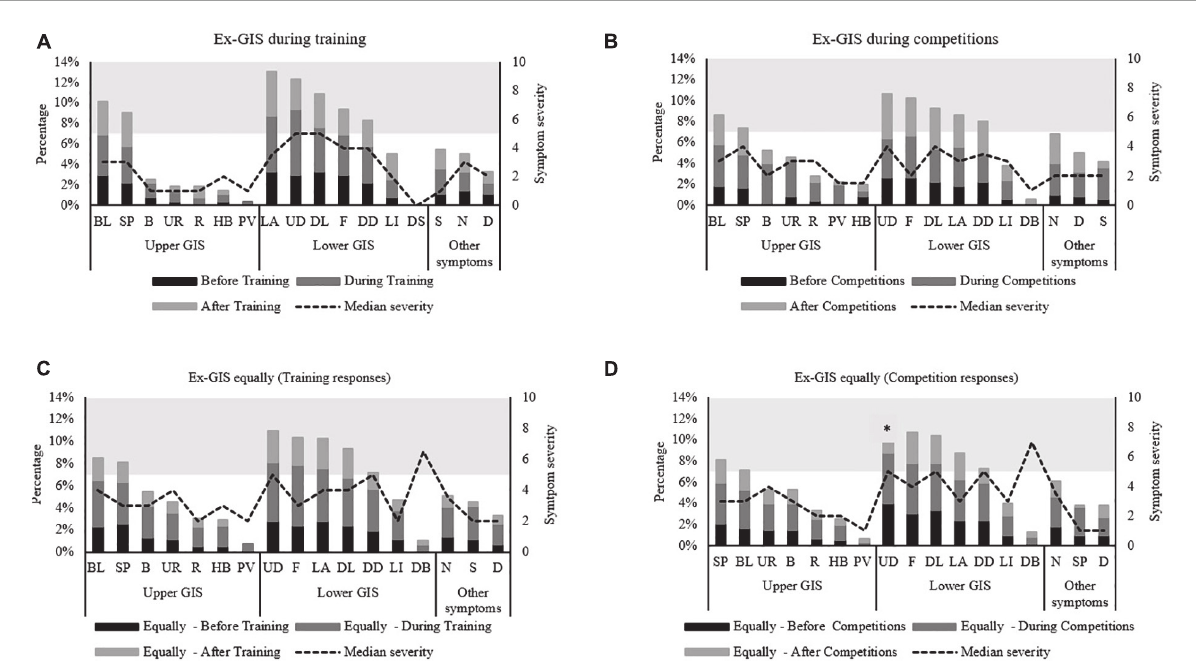
FIGURE1 Combined incidence and median severity rating of gastrointestinal symptoms before, during, and after exercise. Symptoms are listed in upper, lower, and other symptom categories and descending order of incidence. Symptom severity scale is from 0 to 10; 0 = no symptoms, 1–4 mild symptoms, (i.e., the sensation of Ex-GIS but not substantial enough to interfere with exercise workload), 5–9 severe symptoms, (i.e., Ex-GIS substantial enough to interfere with exercise workload/grayscale and above) to 10 extremely severe symptoms, (i.e., indicative of extreme Ex-GIS warranting exercise cessation). (A) Ex-GIS around training only, (B) Ex-GIS around competitions only, (C) Ex-GIS equally around training and competitions (training responses). (D) Ex-GIS equally around training and competitions (competition responses). *Significant difference before and during competitions for UD. B, Belching; BL, Bloating; D, Dizziness; DB, Defecation Bloody Stools; DD, Defecation (Diarrhea); DL, Defecation Loose Stools; F, Flatulence; Ex-GIS, exercise-associated gastrointestinal symptoms; HB, Heartburn; LA, Lower Abdominal Bloating; LI, Left Intestinal Pain; N, Nausea; PV, Projectile Vomiting; R, Regurgitate; S, Stitch; SP, Stomach Pain; UD, Urge to Defecate; UR, Urge to